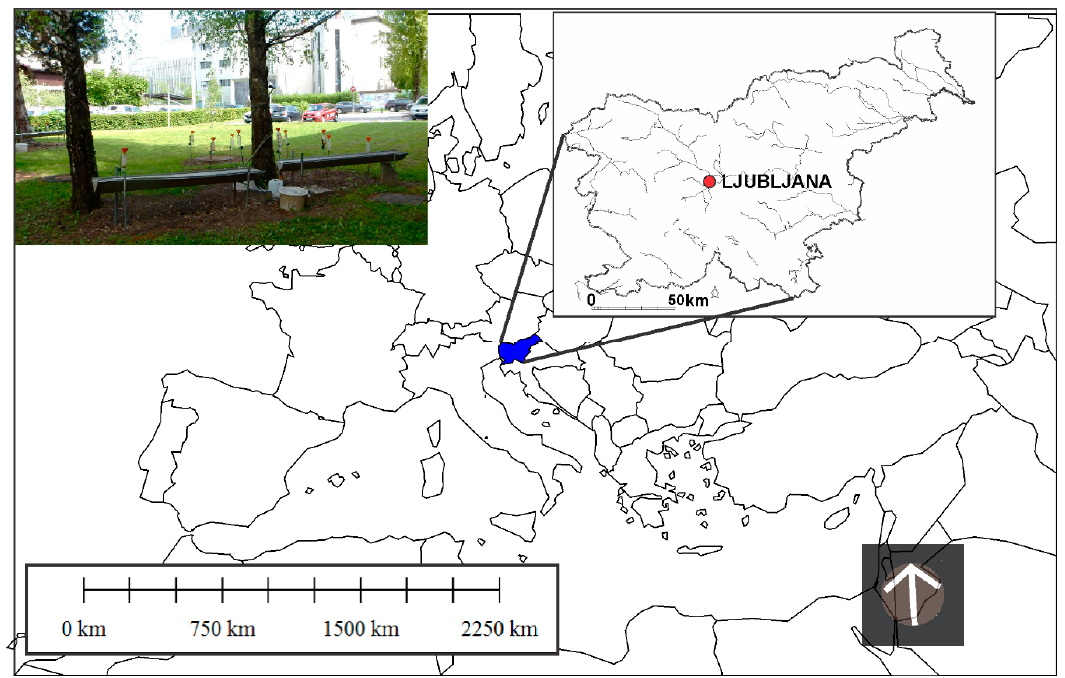
Figure 1. Location of Slovenia on the map of Europe, and a photo from the measuring plot showing the measuring equipment used.